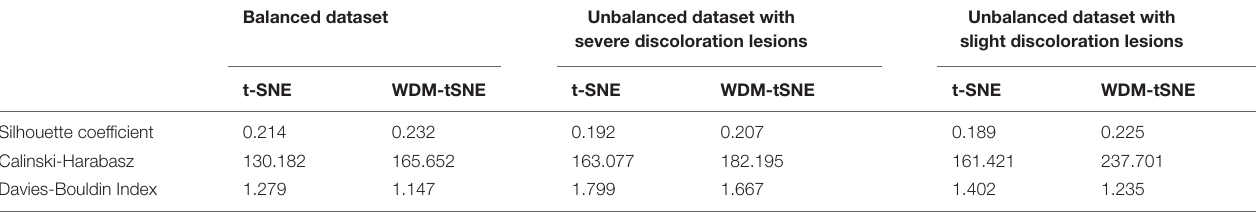
TABLE 4 | The performance of WDM-tSNE on the multiple datasets of lentil. Balanced dataset Unbalanced dataset with severe discoloration